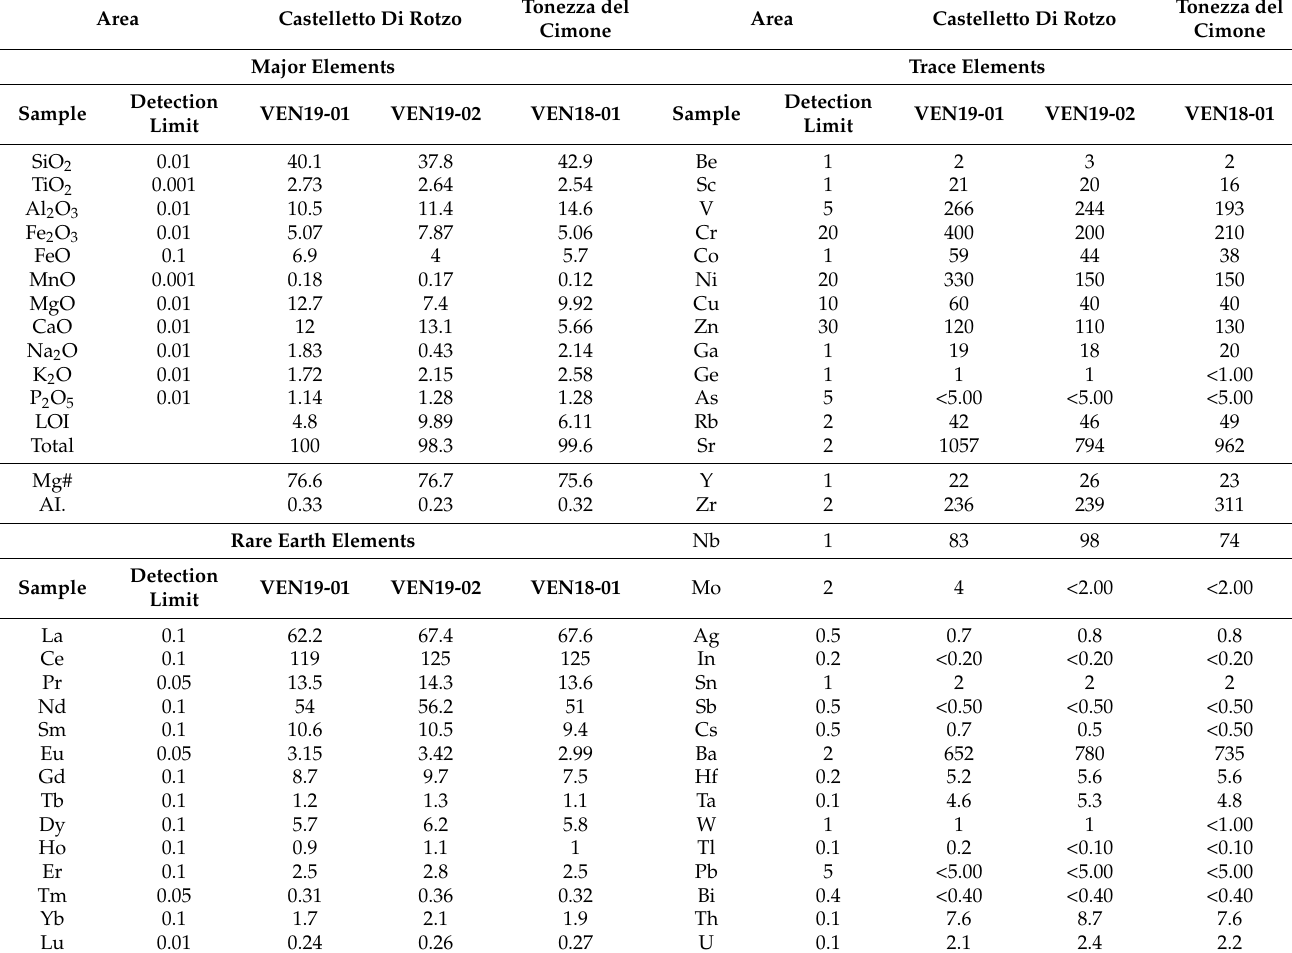
Table 8. Whole-rock geochemical data table (major element in wt %; trace elements and REE in µ